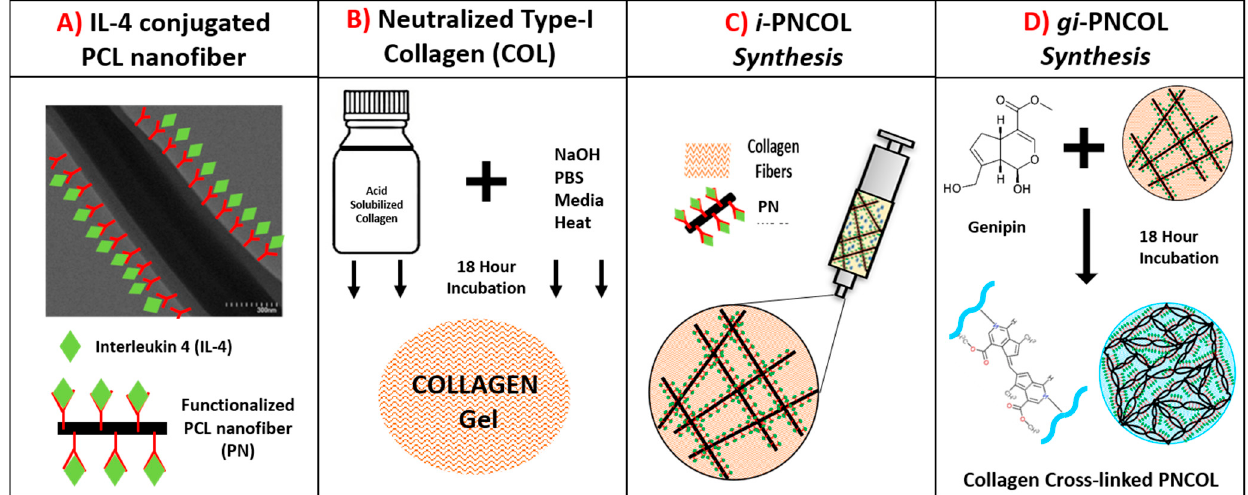
Figure 10. The major steps to synthesize injectable immunomodulatory scaffold, i ‐ PNCOL, and genipin ‐ crosslinked scaffold, gi ‐ PNCOL. ( A ) Interleukin ‐ 4 (IL ‐ 4) conjugation on functionalized polycaprolactone (PCL) nanofibers, ( B ) Neutralizing collagen solution, ( C ) Incorporation of IL ‐ 4 conjugated PCL nanofibers in collagen to create i ‐ PNCOL, ( D ) crosslinking i ‐ PNCOL using genipin to create gi ‐ PNCOL.